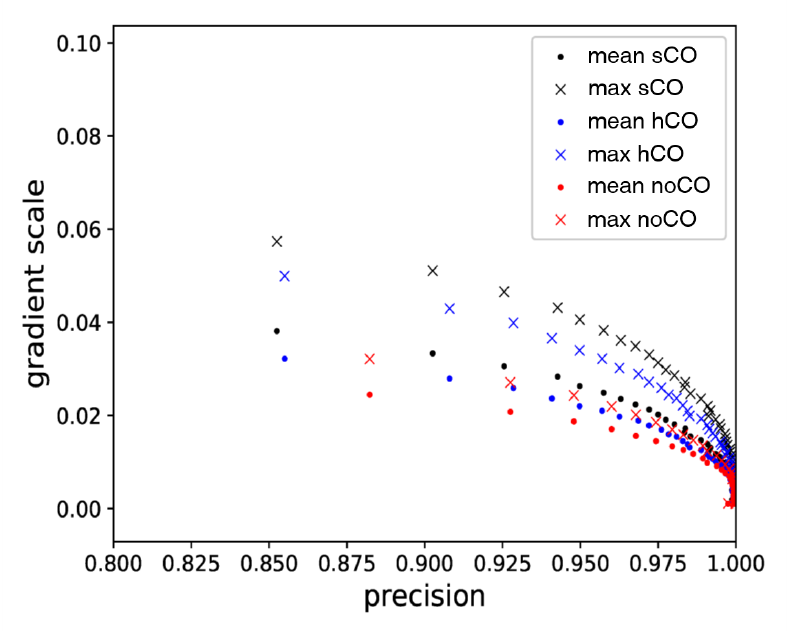
Figure 5. The change in precision-gradient scale in the training phase of the TDC-same task. (sCO: soft Cost-Out, hCO: hard Cost-Out, noCO: without Cost-Out).